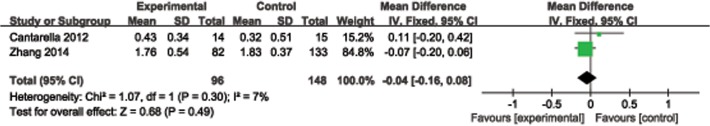
Forest plot of included studies demonstrated the risk ratio for PSG results for tonsillotomy versus tonsillectomy.